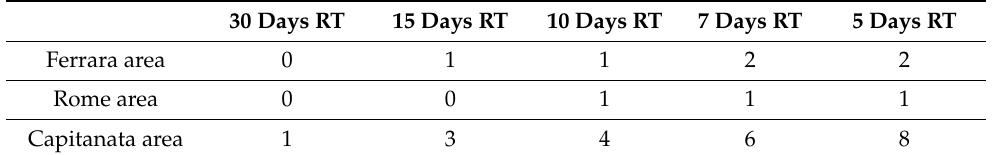
Table 6. Probability of cloud-free bare soil frequency occurrence as a function of satellite revisit time (RT) for the three areas Ferrara, Capitanata, and